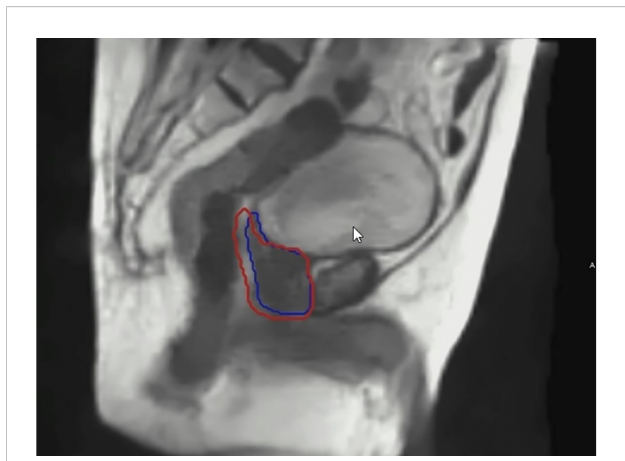
FIGURE 5 An example of real time imaging during a prostate MRgRT treatment. The blue contour depicts the prostate target tracking contour. The red contour depicts the gated treatment envelope